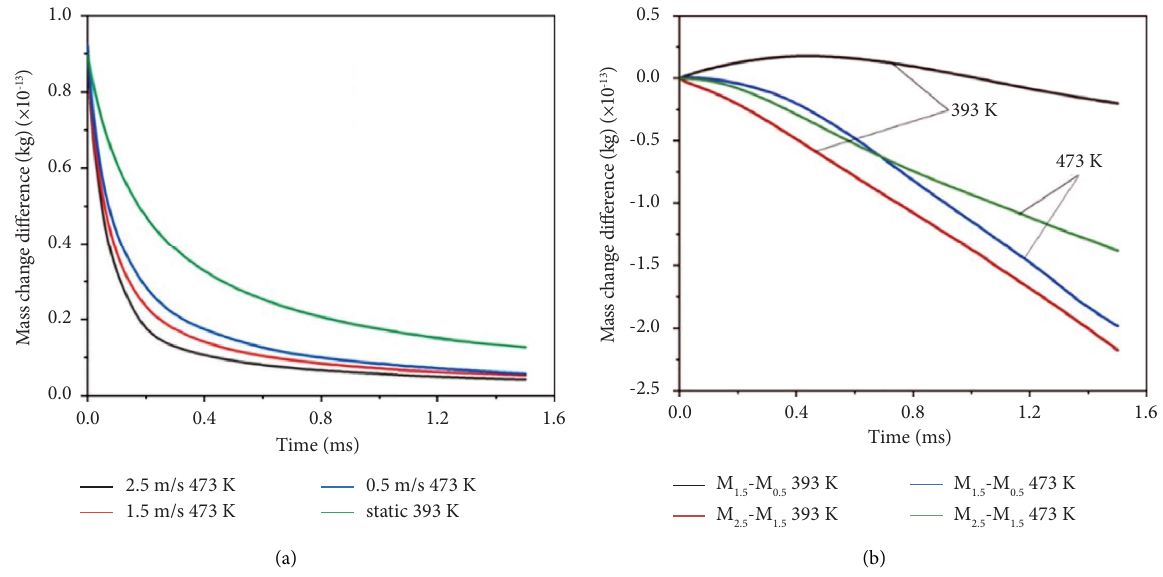
Figure 9: Droplet mass change of collision evaporation. (a) Droplet mass change. (b) Droplet mass change diference.